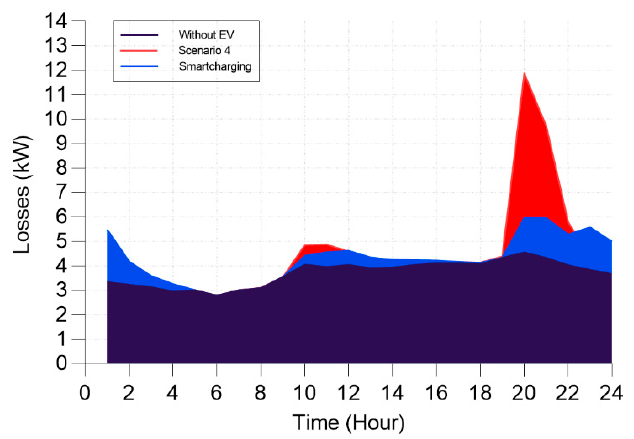
Figure 13. Loss profile, including with smart charging.